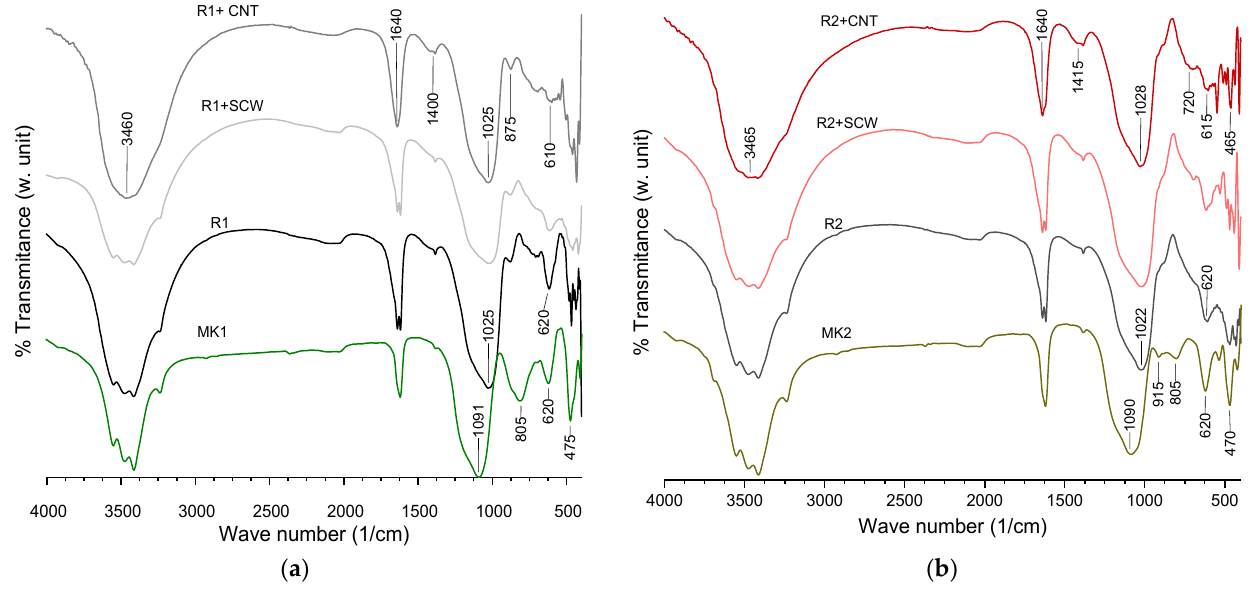
Figure 13. FTIR Spectrum of mixtures at 28 days: ( a ) MK1-based groups, ( b ) MK2-based groups.